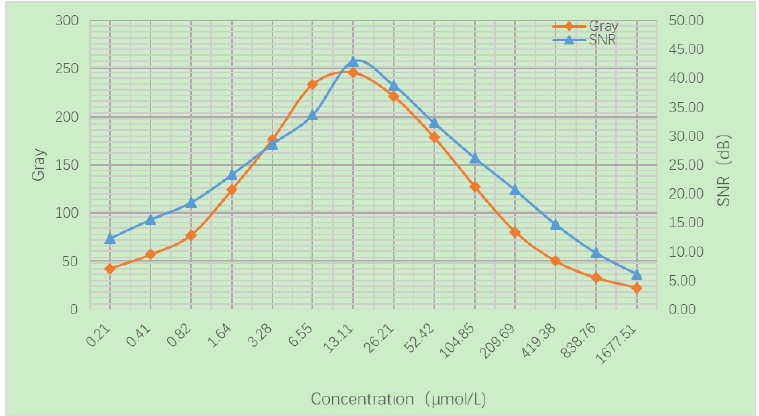
Fig. 2. Gray value and SNR of ICG solution with di®erent concentrations.